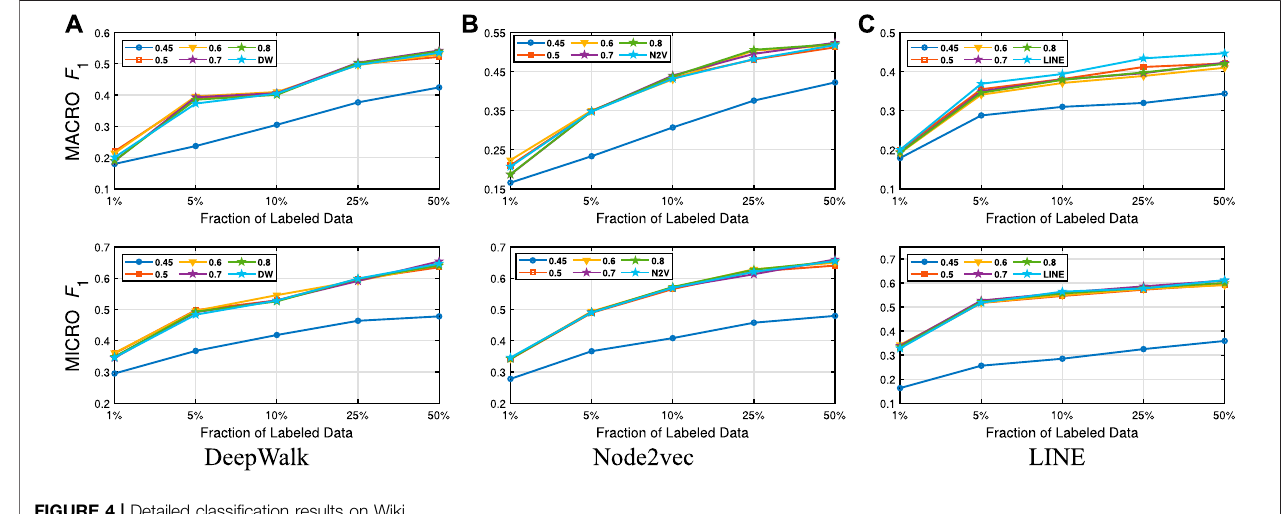
FIGURE 4 | Detailed classi fi cation results on Wiki.